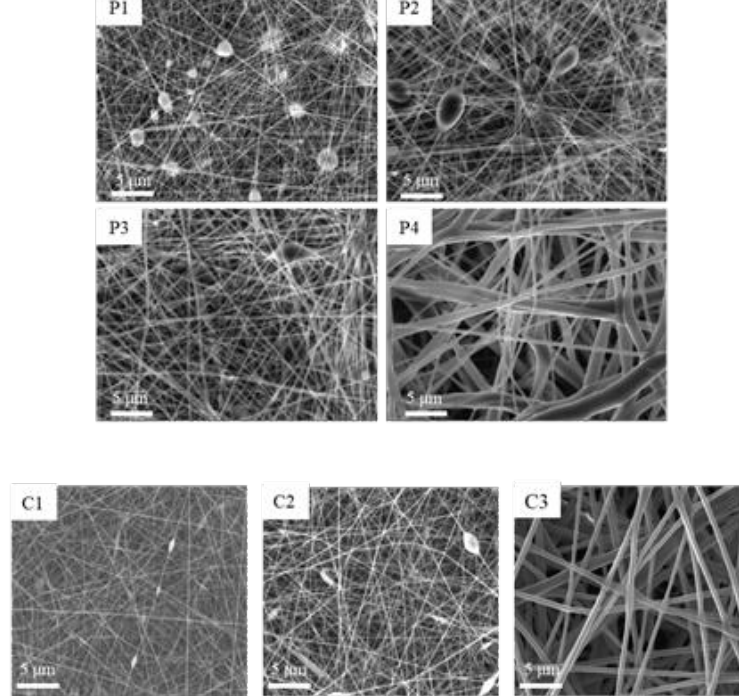
Figure 2. SEM photomicrographs of the electrospun nanofibers prepared from different concentrations of PCL ( P1 – P4 ) and Collagen ( C1 – C3 ), according to Table 1.